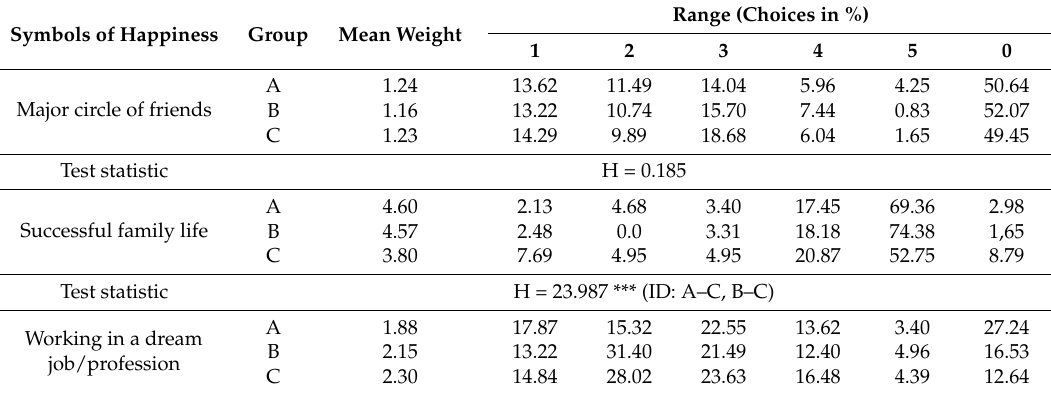
Table 3. Comparison of symbols of happiness scoring in the studied